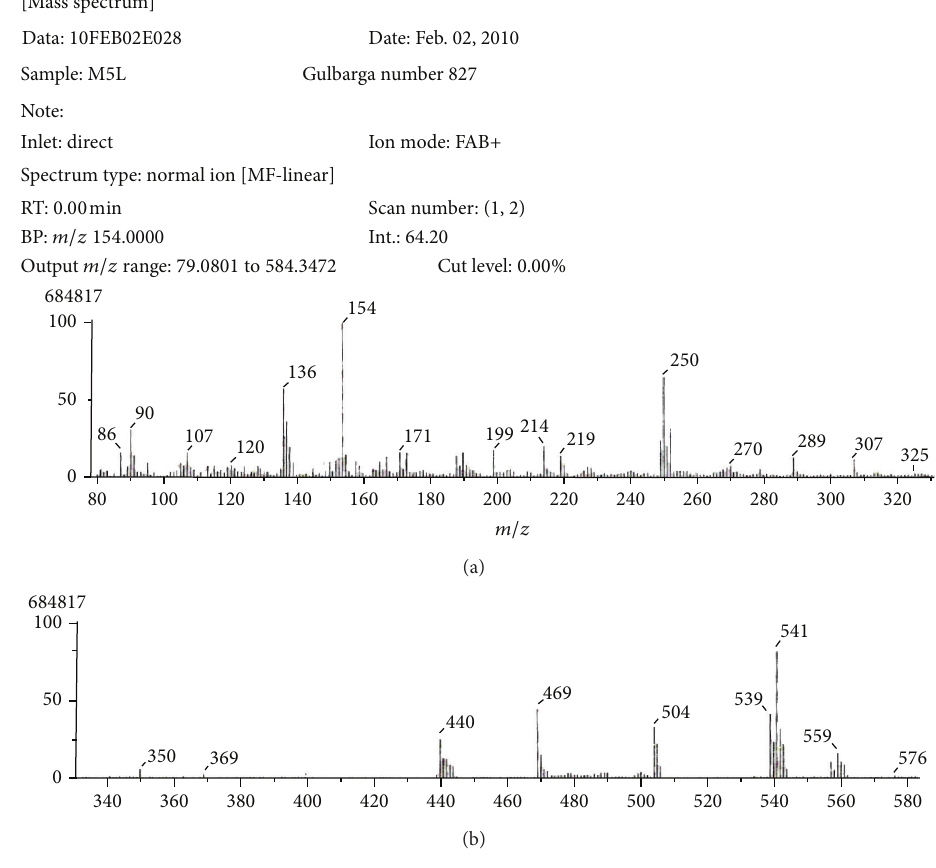
Figure 2: FAB-mass spectrum of Zn(II)